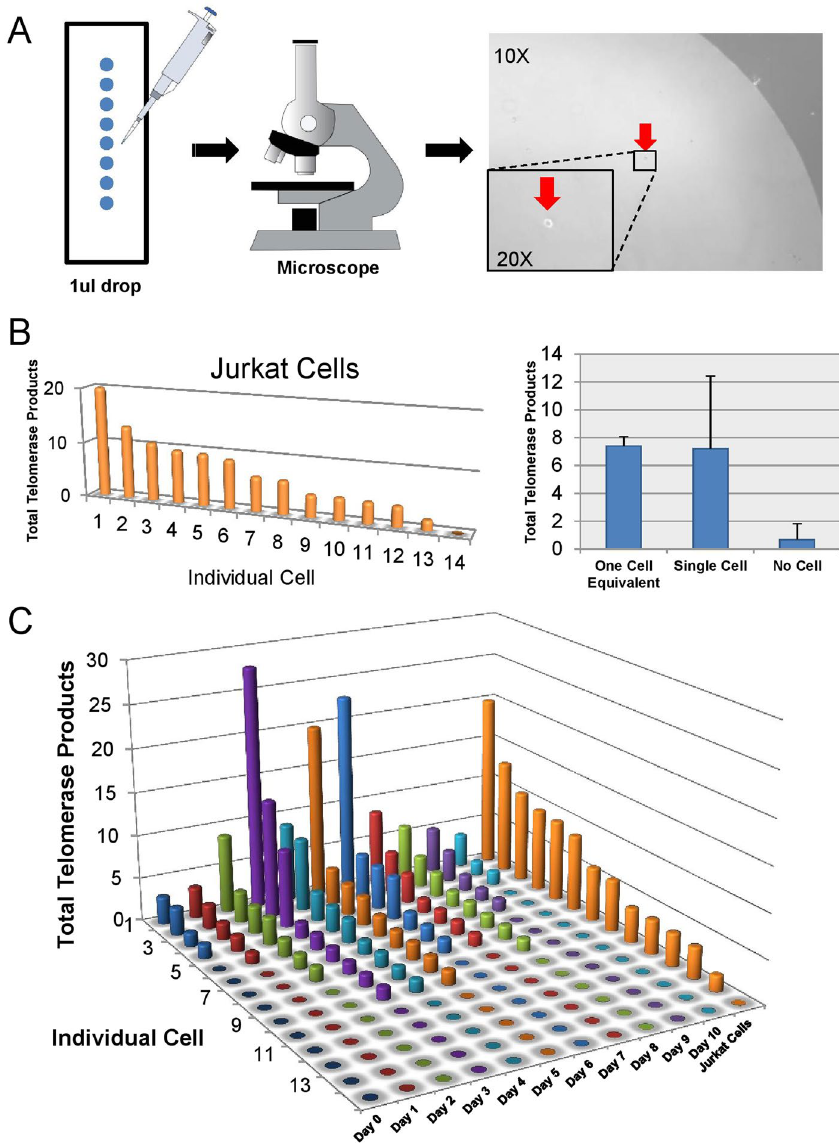
Figure 4. Measurement of telomerase activity at the single-cell level. ( A ) Schematic of single cell isolation procedure. ( B ) Single-cell ddTRAP performed on Jurkat cells. ( C ) Single-cell ddTRAP performed on stimulated T cells from Day 0 to Day